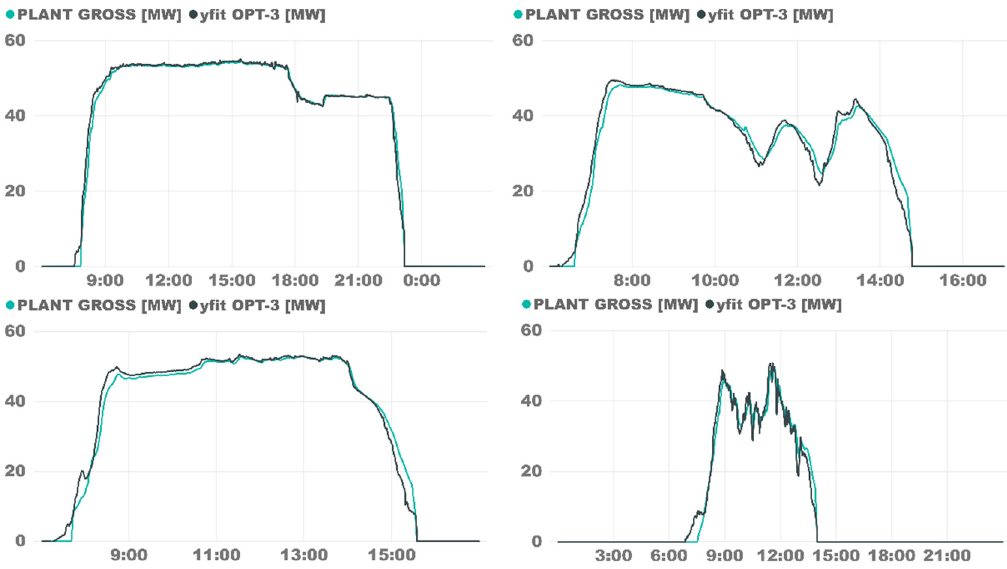
Figure 5. OPT-3 model validation on specific days.